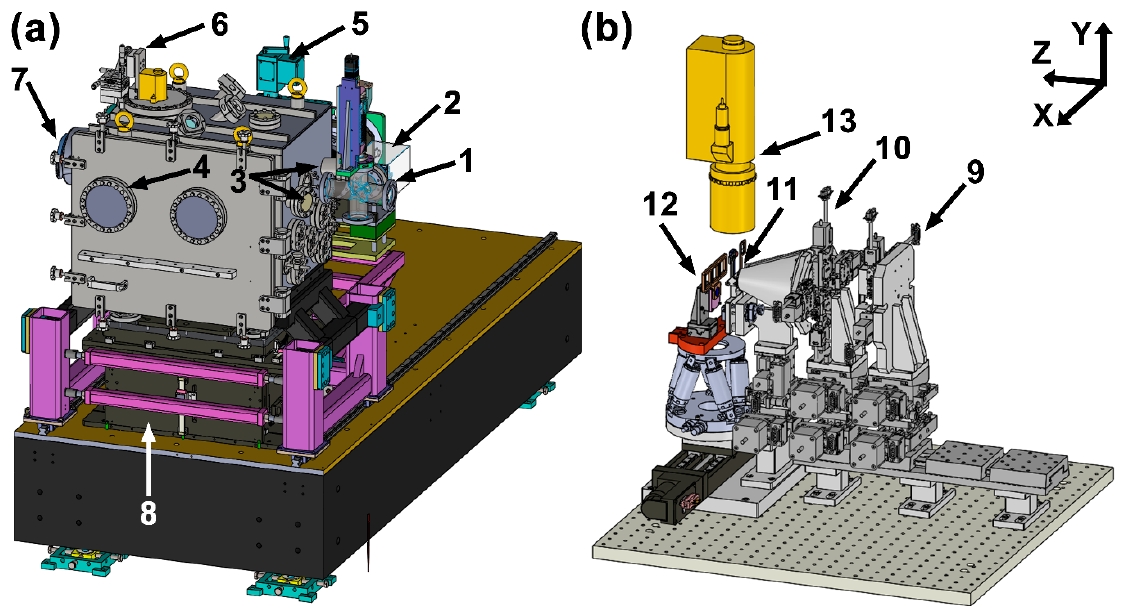
Figure 2. ( a ) The overall schematics of the sample chamber. ( b ) Internal components of the sample chamber. Major components are marked with numbers. (1) X-ray pulse entrance port. (2) Beam position monitor, Ce:YAG (yttrium aluminum garnet), with a linear stage. (3) Pump laser entrance ports with a fixed incident angle to the XFEL pulse at 15 degrees. (4) View port for the sample stage. (5) Gate valve. (6) Long working distance microscope with XYZ manual stages. (7) Exit port to the detector. (8) XY translation stage for the sample chamber. (9) Upstream four-jaw slit on the XY translation stage. (10) Downstream four-jaw slit with cone including XY translation stage. (11) Right-angle mirror with 2-mm clear long hole with XY translation stage and Z-axis manual stage. (12) Sample stage. (13) Long working distance microscope.